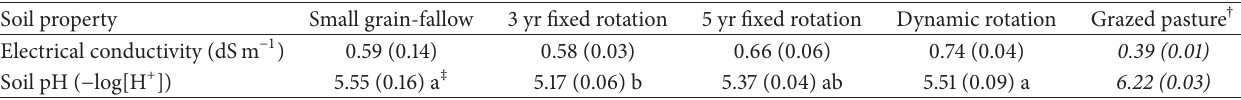
measured in grazed pasture due to excessive soil wetness at time of sampling. ‡ Table 2: Crop diversity effects on electrical conductivity and soil pH at 0–10cm for long-term crop and pasture treatments near Mandan, ND.